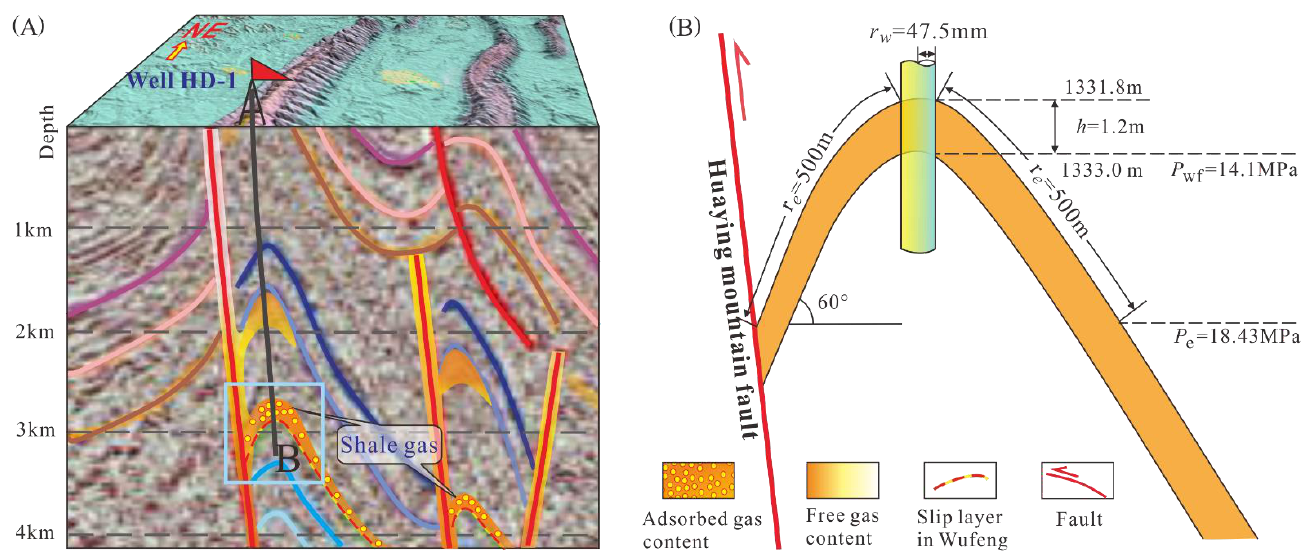
Figure 10. Geological characteristics in the surroundings of well HD-1. ( A ) Projection of well HD-1 in the seismic section showing the location of well HD-1 in association with the core of the Huayingshan anticline; ( B ) geometrical and physical parameters defining the reservoir section of well HD-1 used for estimating the in situ permeability from Equation (3).